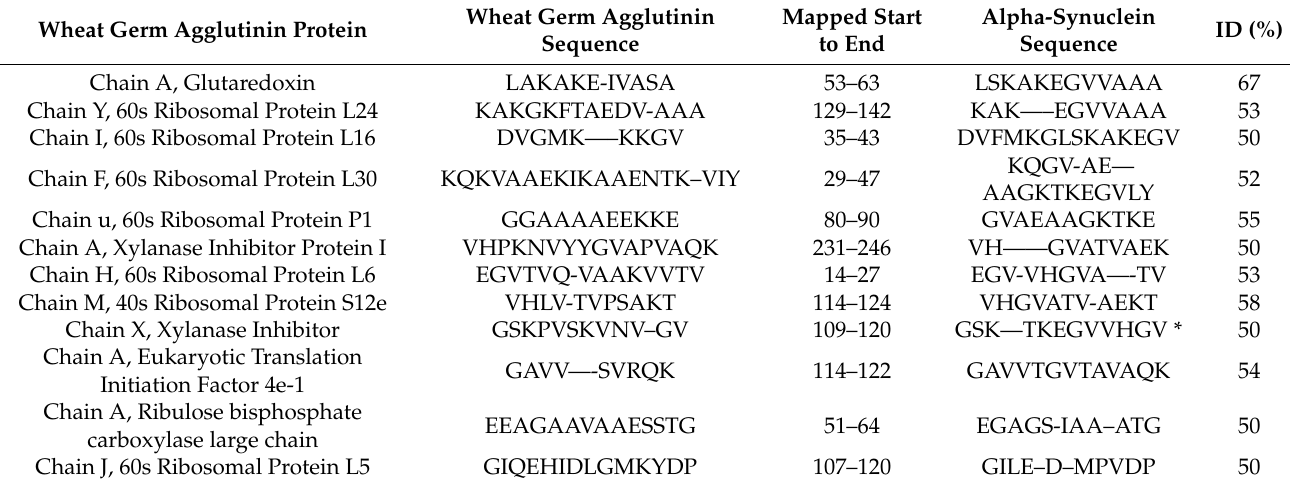
Table 4. Potential cross-reactive epitopes between alpha-synuclein proteins and wheat germ agglutinin. Wheat Germ Agglutinin